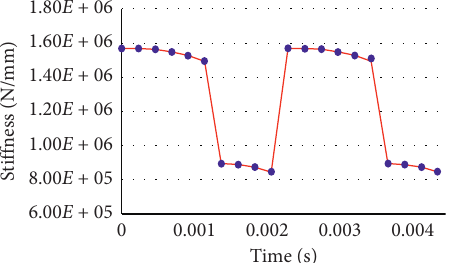
Figure 4: The meshing stiffness of the gear pair.